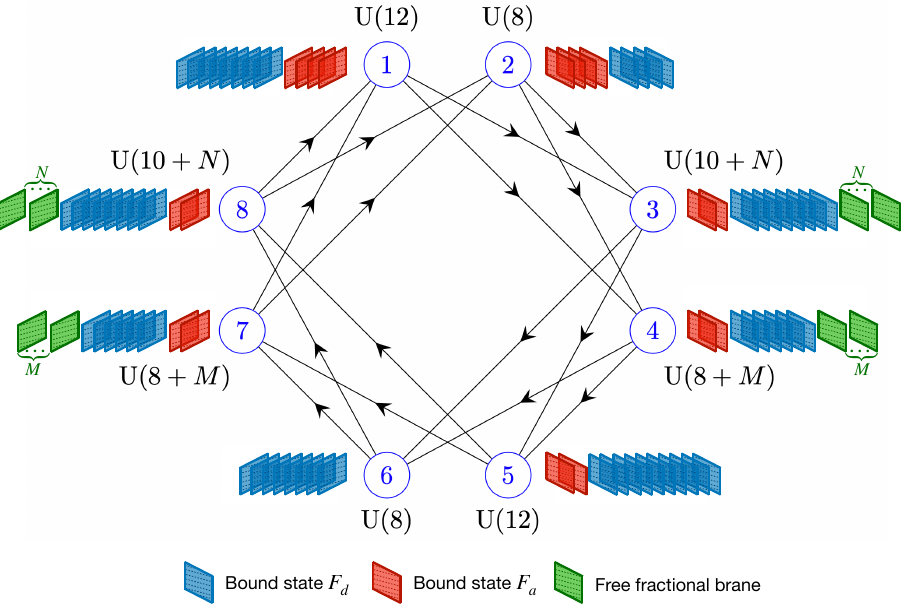
Figure 10 . Large model I quiver diagram for a D3-brane at a dP 5 -singularity with the bound state 2 F indicated in red and 2 F in blue. The green fractional branes do not contributing to any a d bound